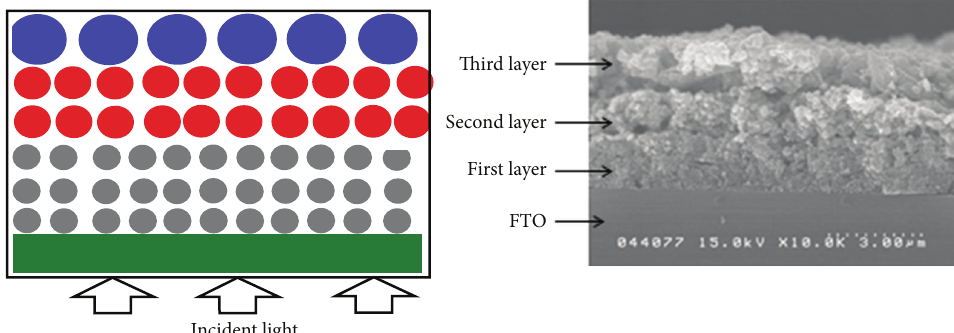
Figure 9: The schematic diagrams of triple-layer structures with the different particle sizes in the first (bottom), second (middle), and third (top) layers.